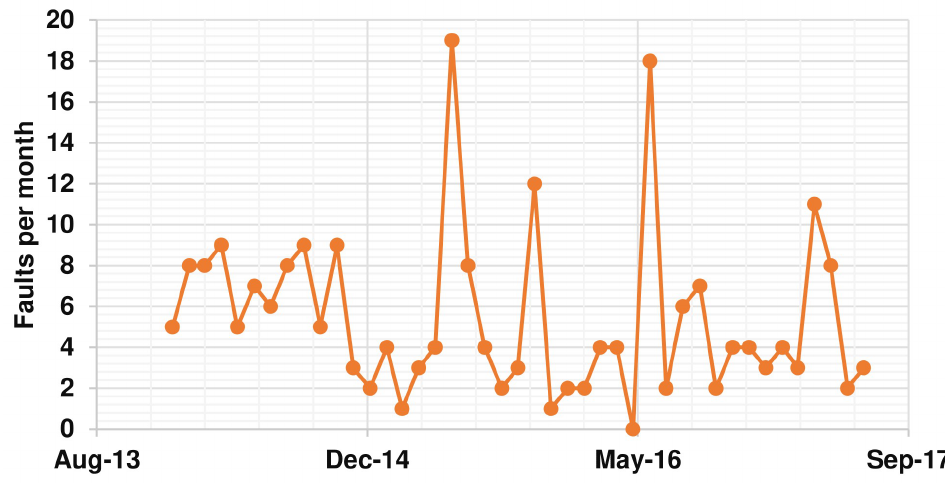
Figure 7. Historical trend of faults per